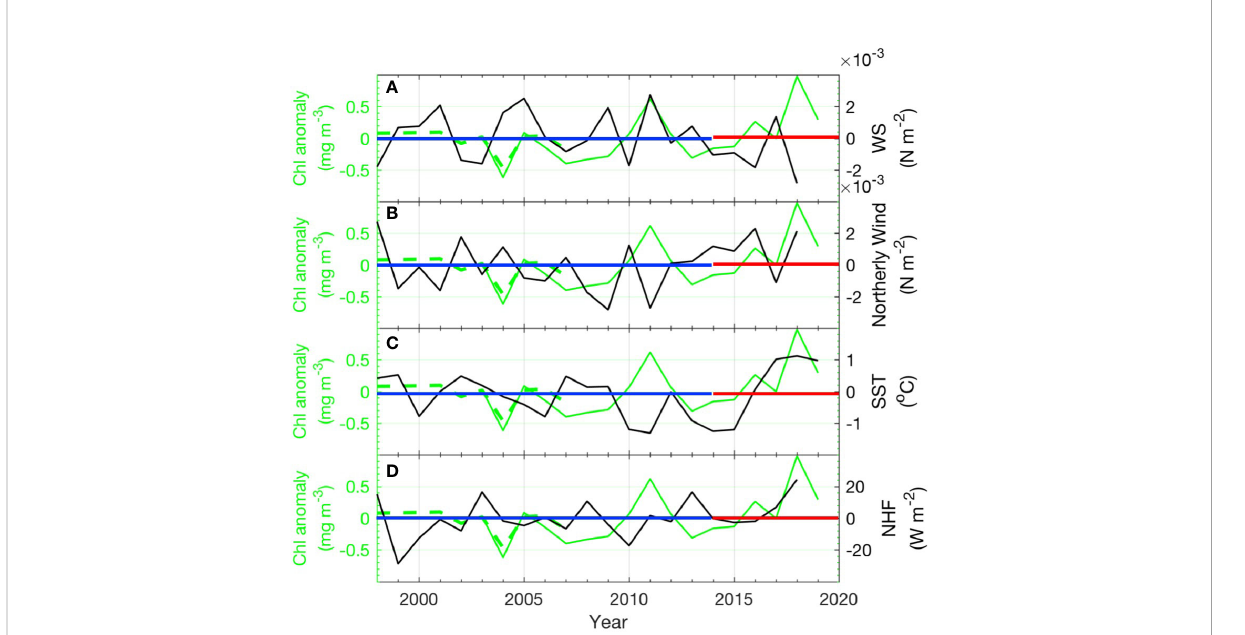
FIGURE 9 Time series of the spring time spatial mean Chl -a in the triangular area (Figure 8B marked with +) with (A) wind stress anomaly, (B) northerly wind stress anomaly, (C) SST anomaly, and (D) NHF anomaly. The dashed green line denotes the SeaWiFS Chl -a and the green line denotes the MODISA Chl -a . The blue straight line denotes the negative PDO period, and the red straight line denotes the positive PDO period.